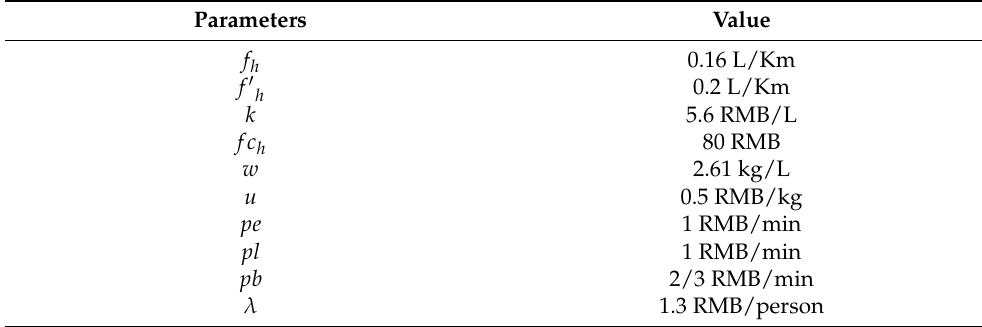
Table 2. The relevant parameters of the